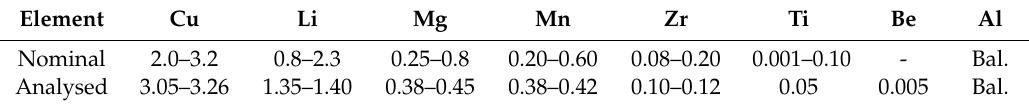
Table 1. Nominal and analysed chemical composition of 2A97 alloy (wt